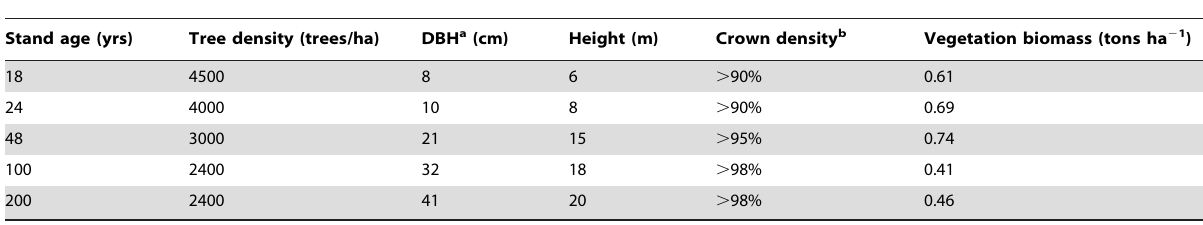
Table 1. Characteristics of the forest stands at Huanglongshan.